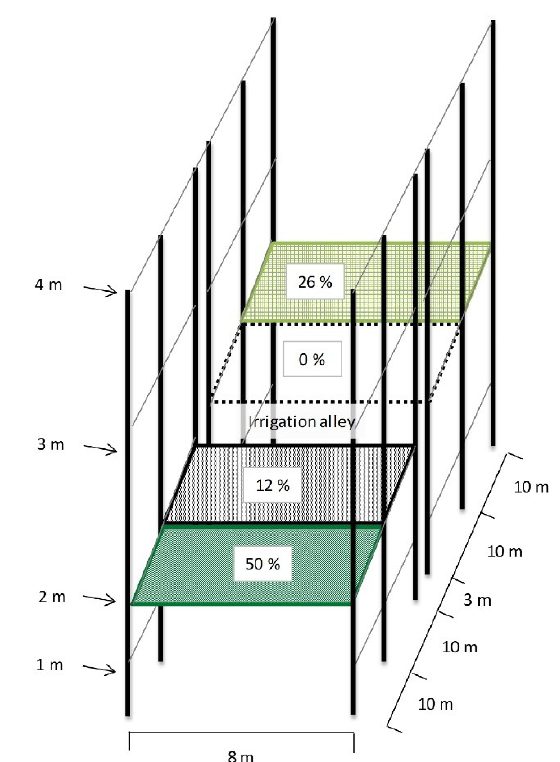
Figure 2. Construction outlines of the artificial shading system in East-to-West-View, exemplarily shown for one repetition. In this example, the nets are installed at a height of 2 m. The numbers in the boxes are the reduction values of solar radiation. The 2nd (12%) and the 3rd (0%) plot were separated by an irrigation alley of 3 m width.